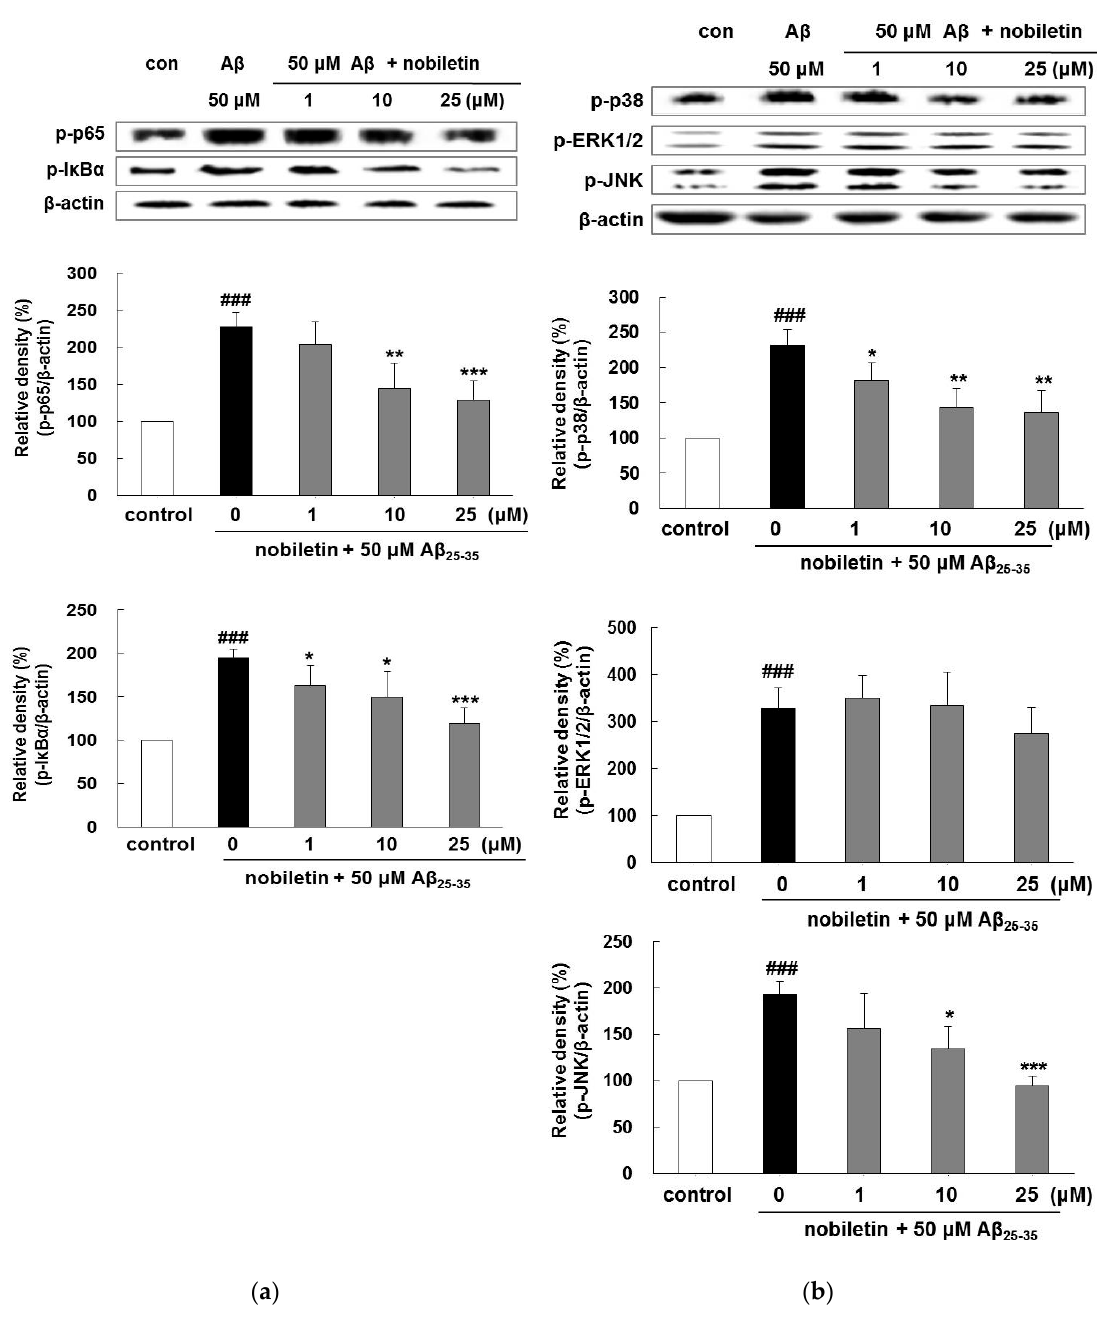
Figure 4. Inhibitory properties of nobiletin in the NF- κ B / MAPKs pathway. Phosphorylation of ( a ) p65 and I κ B- α , and ( b ) p38, ERK1 / 2, and JNK was examined by Western blot analysis. The cells were pretreated with nobiletin for 1 h and then exposed to A β 25-35 for 4 h (p65 and I κ B- α ) or 1 h (p38, ERK1 / 2, and JNK). Quantification of band intensities was conducted using Image J software and normalized to β -actin. ### p < 0.001 vs. control. *** p < 0.001, ** p < 0.01, and * p < 0.05 vs. A β 25–35 .